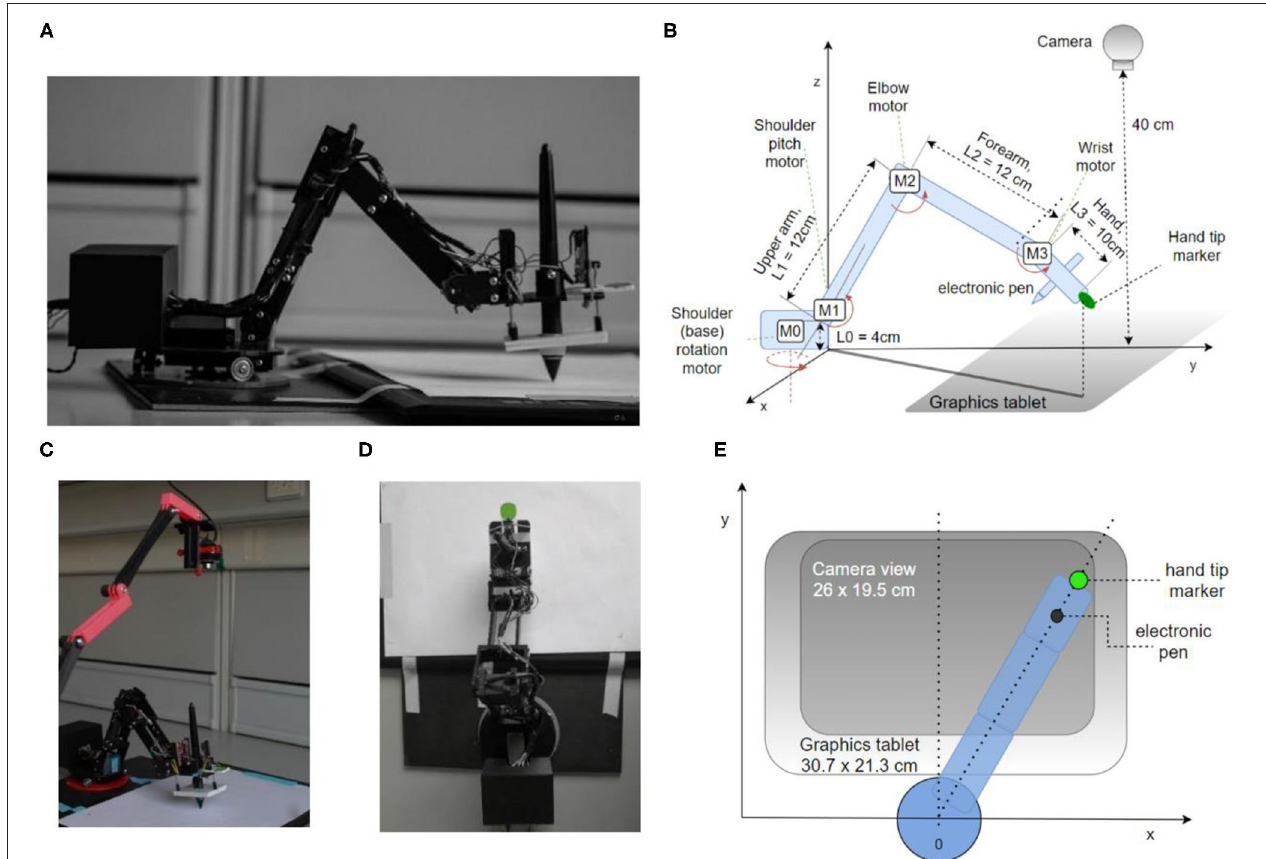
FIGURE 1 | The robot arm system design and implementation. (A) Side view showing the body of the robot, enclosed microcontroller, electronic pen, and tablet. (B) Diagram of the robot arm in perspective view with arm segments L0–L3, motors M0–M3, camera, tablet, pen, and marker of tip position. (C) Photo of the experimental setup, including the top camera. (D) Top view photo (camera’s viewpoint), the green circle is used by the visual system as the marker of hand tip position. (E) Diagram of the robot from the top view.